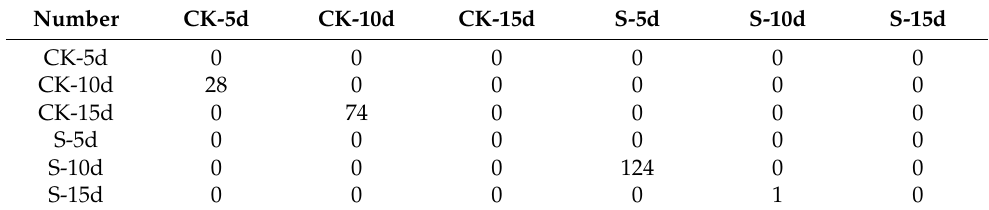
Table 1. CircRNA differentially expressed genes